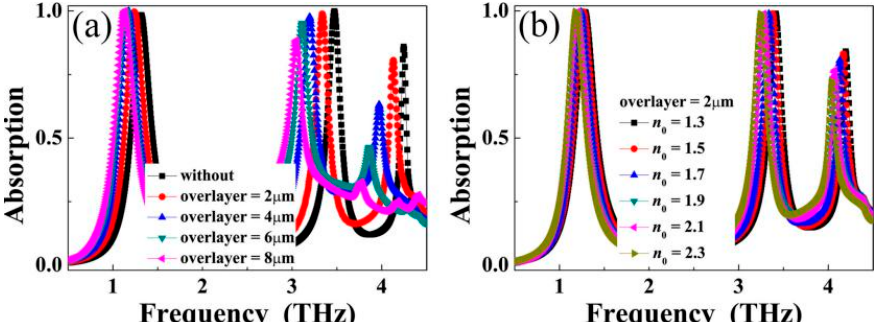
Figure 4. ( a ) Absorption spectra of the thickness change of the overlayer; ( b ) absorption spectra of refractive index change of the overlayer (and here its thickness is 2 µm).